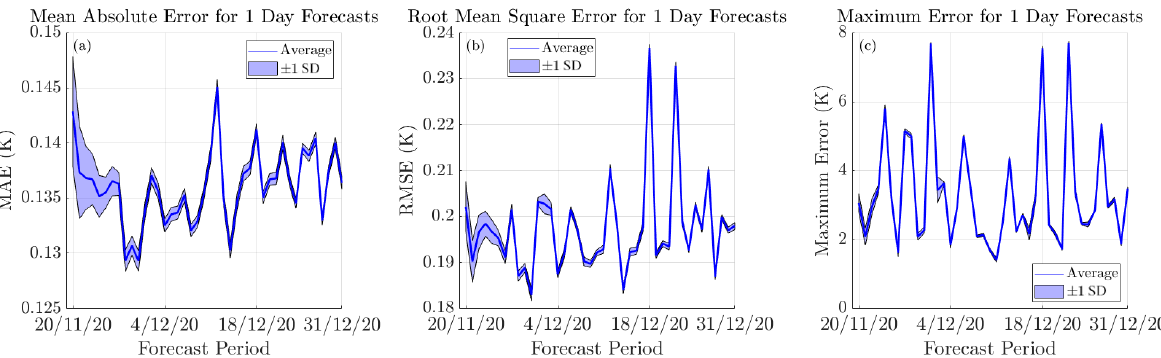
Figure 6. The evolution of the error for the 1d forecasts. The mean absolute error in the forecast over the entire ocean is depicted in panel (a) , the root-mean-square is shown in panel (b) and the maximum error is presented in panel (c) . The model average is represented using a dark blue line, and ± 1 standard deviation is represented by the shaded outline above and below the average.